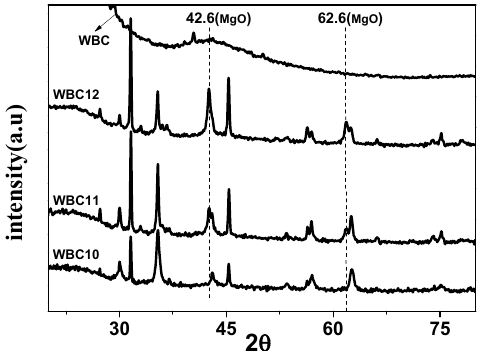
Figure 3. XRD patterns of WBC and WBC1x.